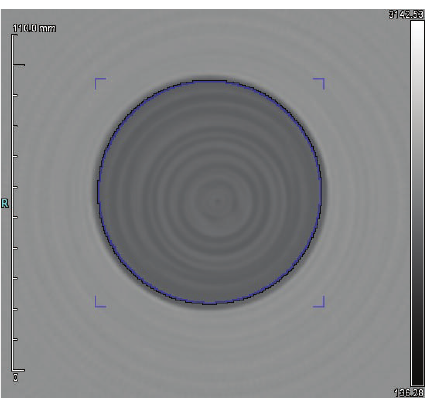
Figure 9: Speed-of-sound image of a uniform phantom (grayscale in m/s, max 3142 m/s, min 136 m/s).